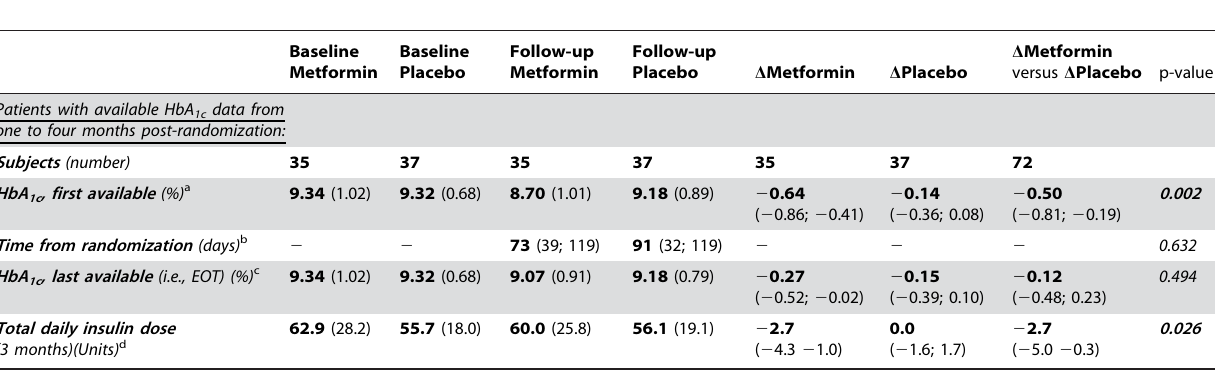
Table 6. Effect of metformin versus placebo on follow-up (intermediate and study visit) levels of HbA 1c and insulin doses in 72 patients with type-1 diabetes during a one year